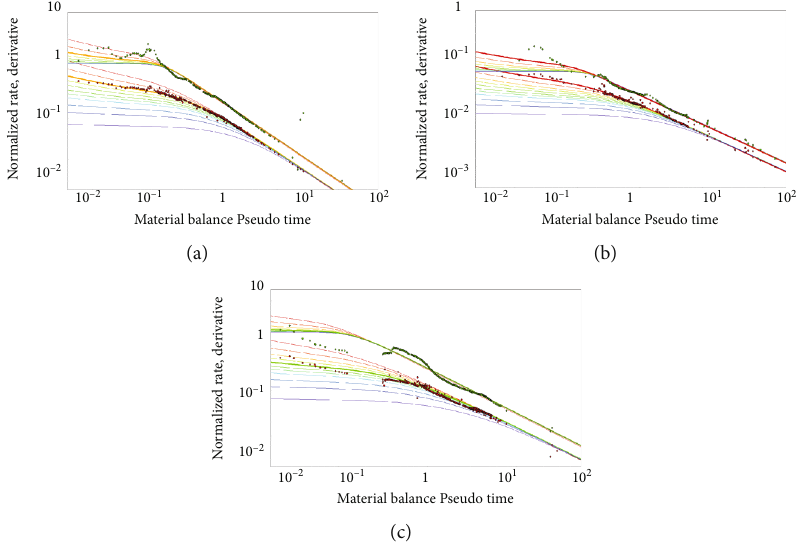
Figure 9: Fitting of A-G method type curve and production data: (a) L2-3, (b) Y2-8, and (c)